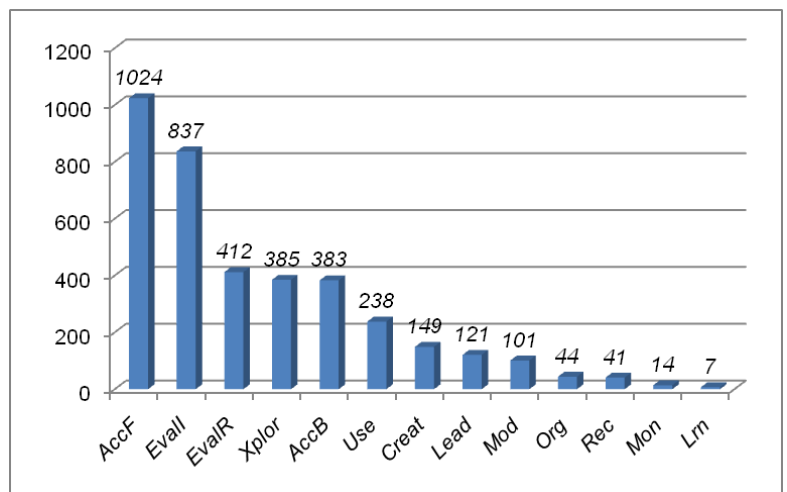
Figure 1 . Frequency of types of search tactics